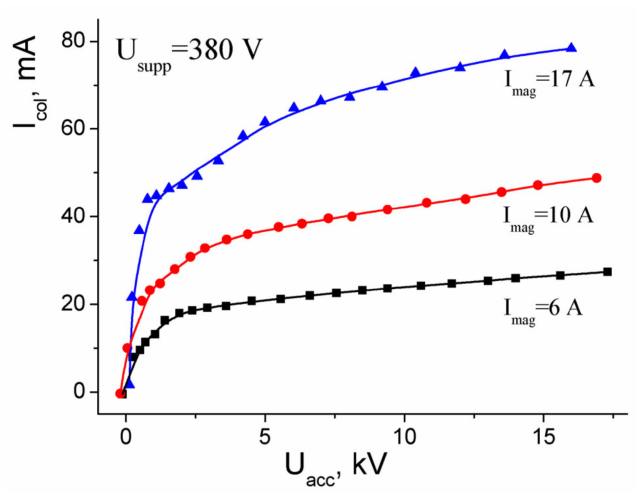
Figure 5. Ion beam current dependence on accelerating voltage for different magnetron discharge currents. Copper magnetron target, copper vacuum arc cathode.